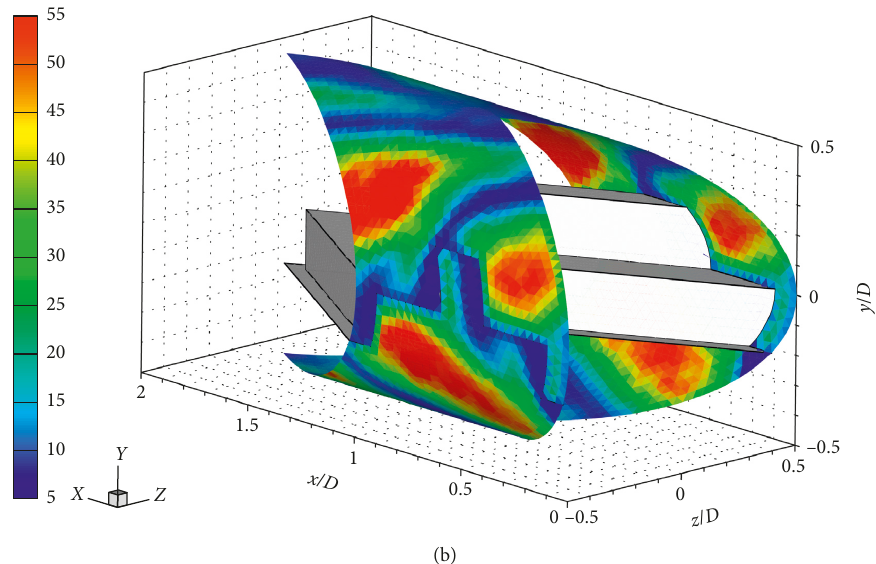
Figure 8: Local Nusselt number contour on the tube wall of the heat exchanger tube inserted with the V-wavy surface at α for (a) V-Downstream and (b)